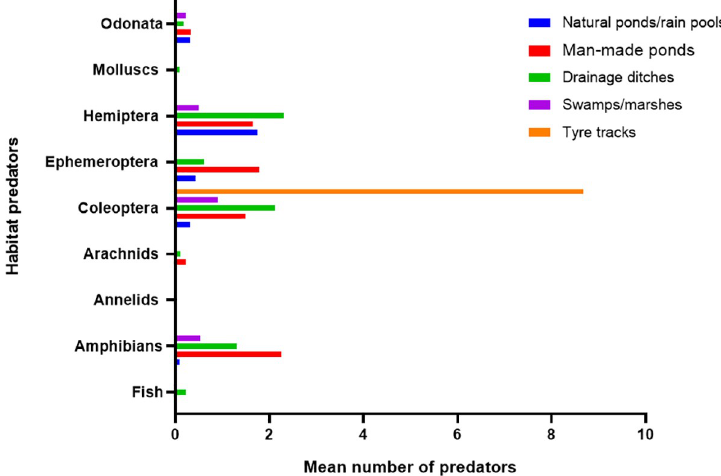
Fig 3. Distribution of aquatic predators in the various habitats. Odonata: damselfly/dragonfly, Molluscs: snails/ slugs/mussels, Hemiptera: backswimmer/giant water bugs/cacidas, Ephemeroptera: mayfly, Coleoptera: water beetles/ weevils, Arachnids: spiders/ticks/mites, Annelids: Segmented worms, Amphibians: frogs/toads/tadpoles, Fish: tilapia.